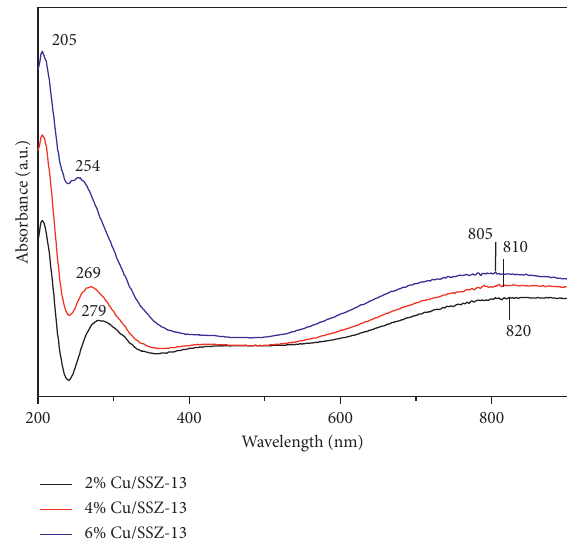
Figure 5: UV-Vis DRS spectra of the Cu/SSZ-13 ( x � 2, 4, 6%)